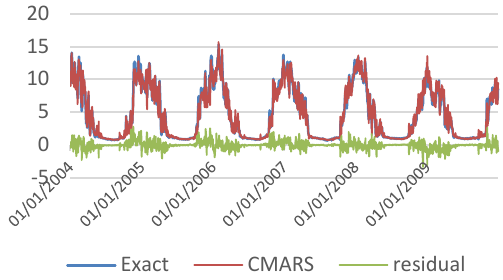
Figure 1. Exact values and RR approximation of natural gas consumption for one-day-ahead prediction based on training data